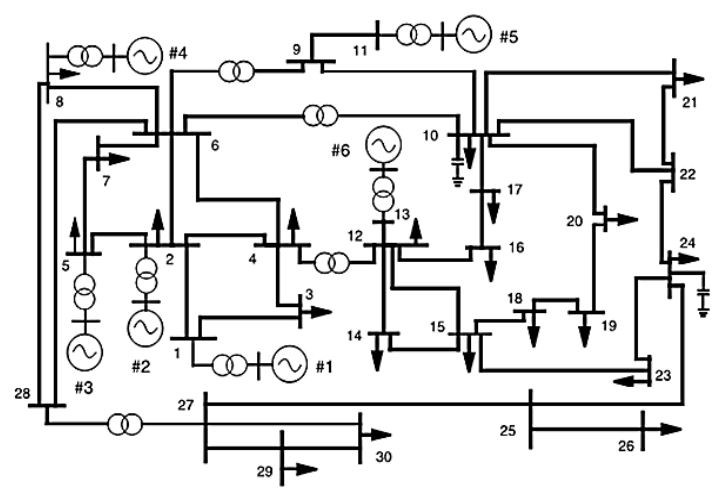
Figure 4. Single-line diagram of IEEE 30 bus test system.